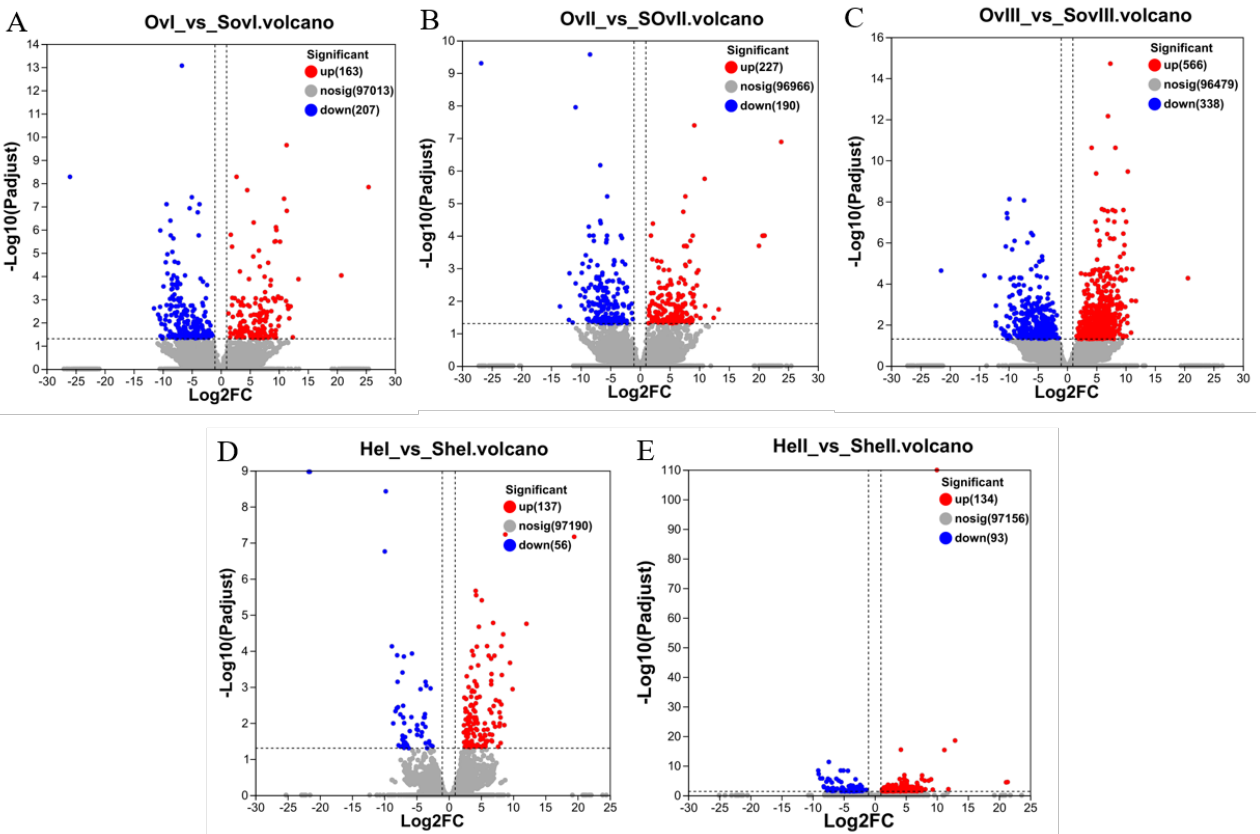
Figure 2. Volcano plots of DEGs. ( A ) Volcano plot of DEGs identified from OvI_vs_SOvI , ( B ) OvII_vs_SOvII , ( C ) OvIII_vs_SOvIII , ( D ) HeI_vs_SHeI , and ( E ) HeII_vs_SHeII . Red and blue dots indicate significantly up- and downregulated transcripts, respectively. Gray dots represent transcripts with non-significant differences.